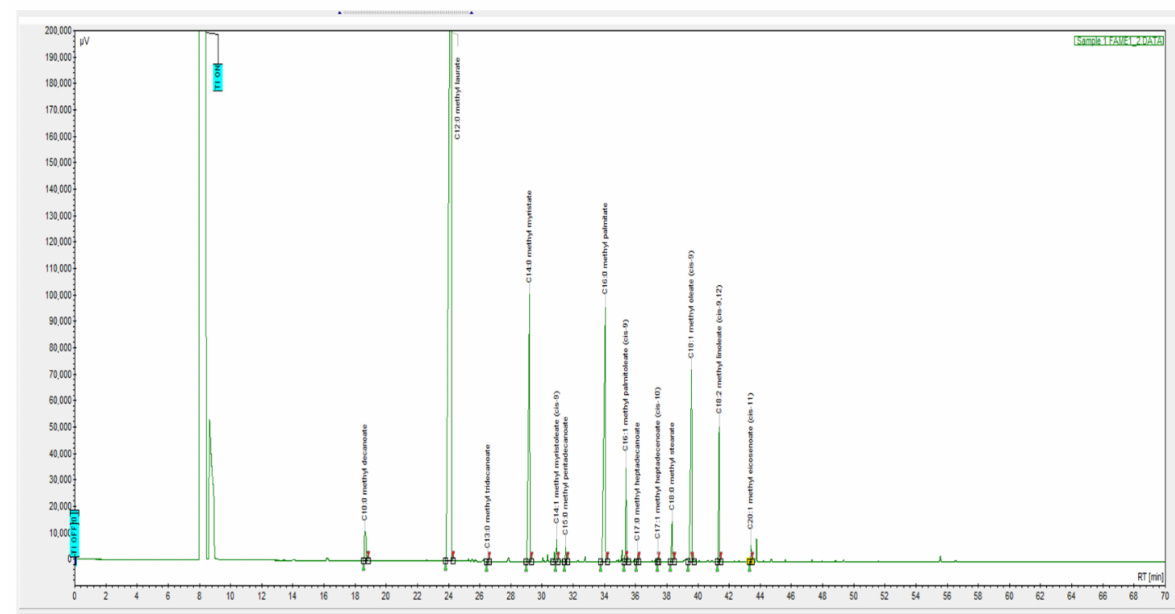
Figure 3. Chromatogram of fat of Hermetia illucens